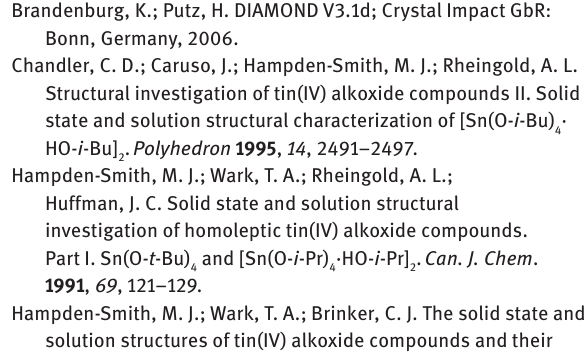
Figure 1 Molecular structure of Sn probability ellipsoids and the crystallographic numbering scheme